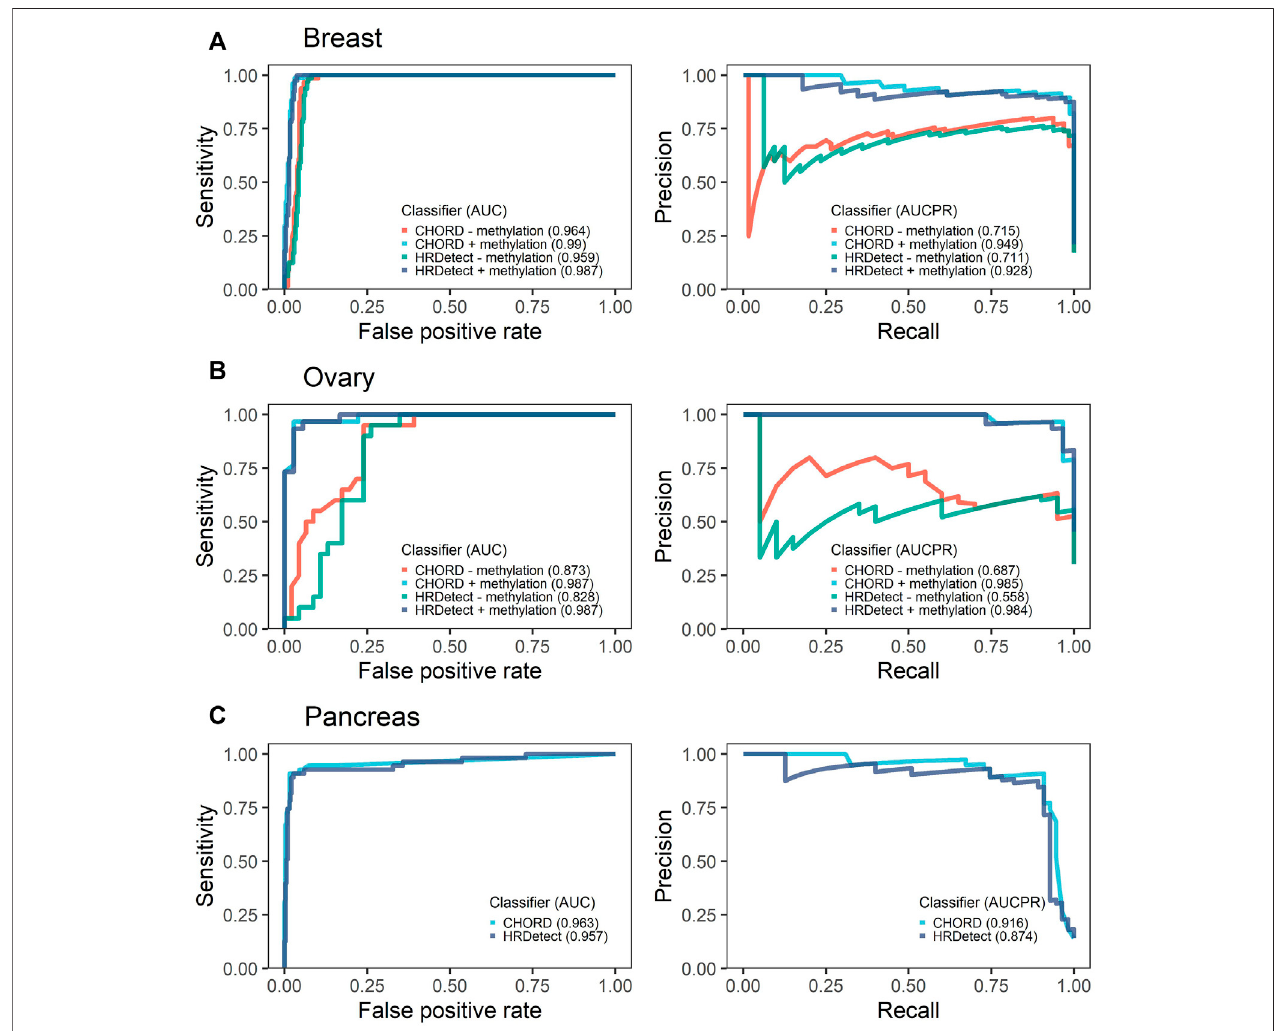
FIGURE 3 | Receiver operating characteristics (ROCs) with the respective area under the curve (AUC) and precision-recall curves (PR) with the area under the precision-recall curve (AUCPR) showing the performance of CHORD and HRDetect classi fi er with and without methylation data for breast (A) and ovarian cancers (B) . Pancreas (C) cancer data do not have methylation